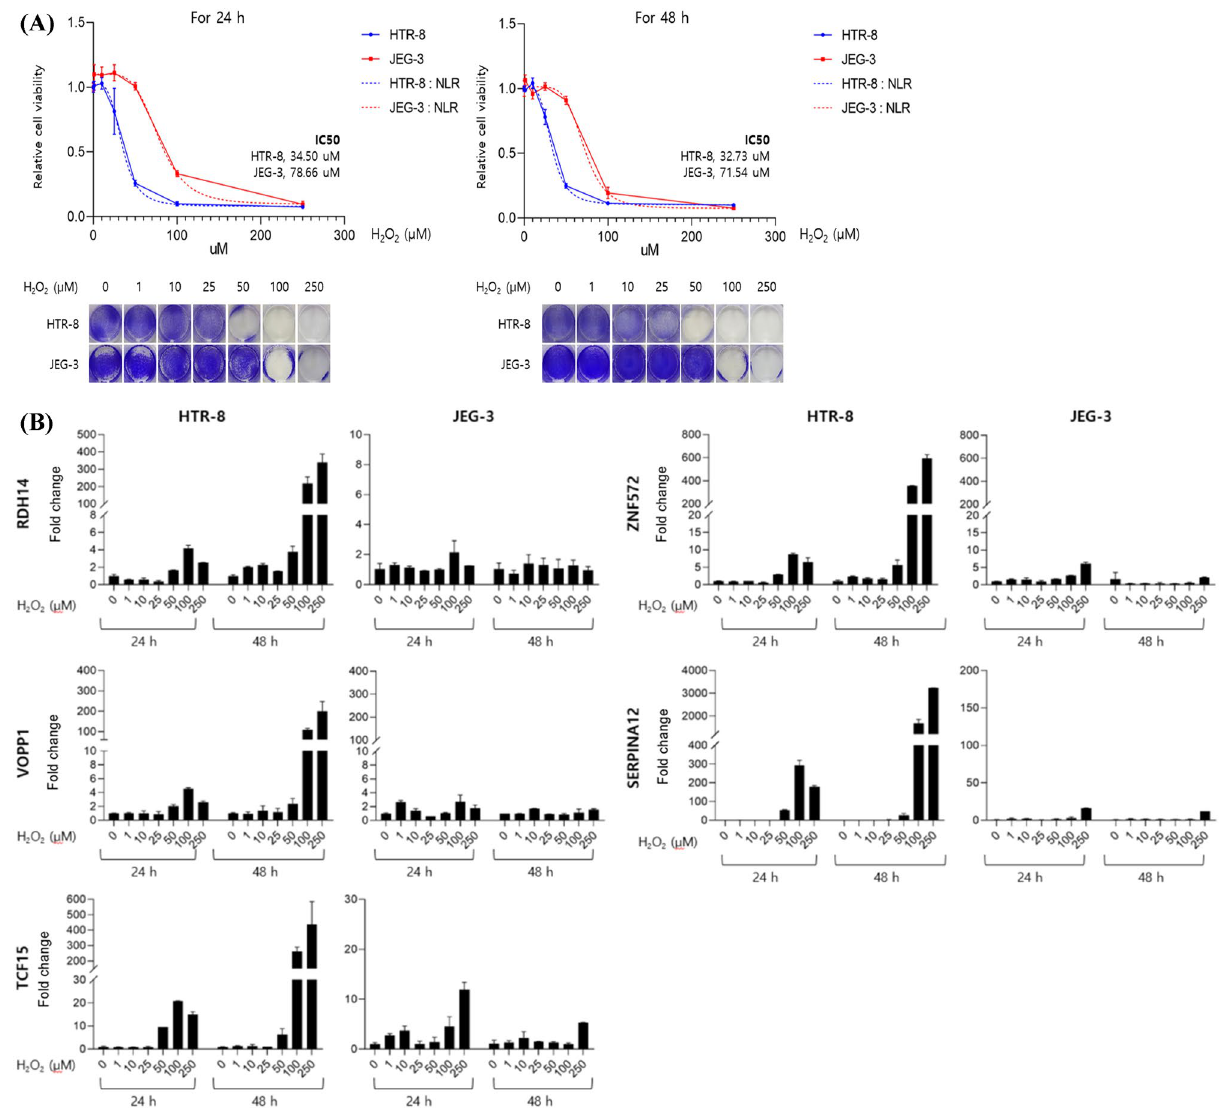
Figure 5. Validation of candidate genes in H 2 O 2 treated human trophoblast cell line HTR-8/SVneo and JEG-3 cell lines. (A) Time- and dose-dependent cytotoxic activity in the HTR-8/SVneo and JEG-3 cell lines (B) qRT- PCR validation of the expression of 5 chosen differentially expressed genes in H 2 O 2 treated human trophoblast cell line HTR-8/SVneo and JEG-3 cell